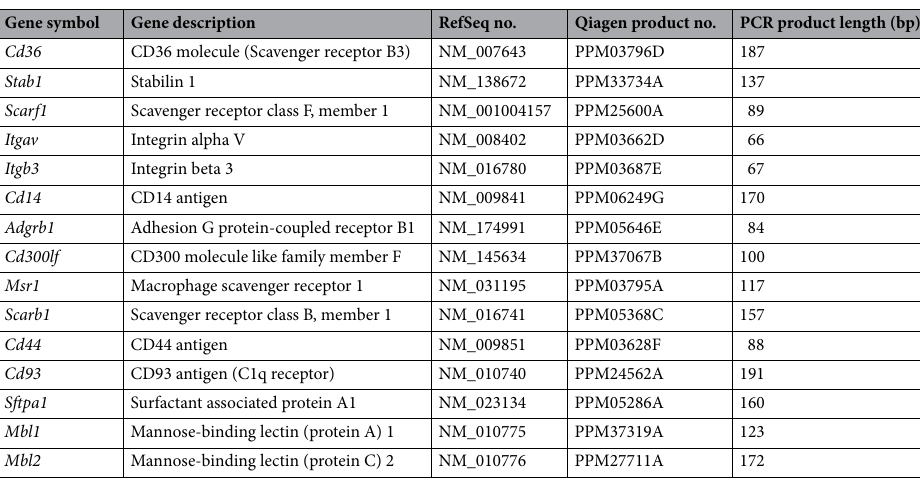
Table 1. Genes, oligonucleotide primers and PCR product lengths ( Mus musculus ). RefSeq No., GenBank reference sequence accession number; Bp, base pairs; Qiagen product No., Product numbers of Qiagen Primer